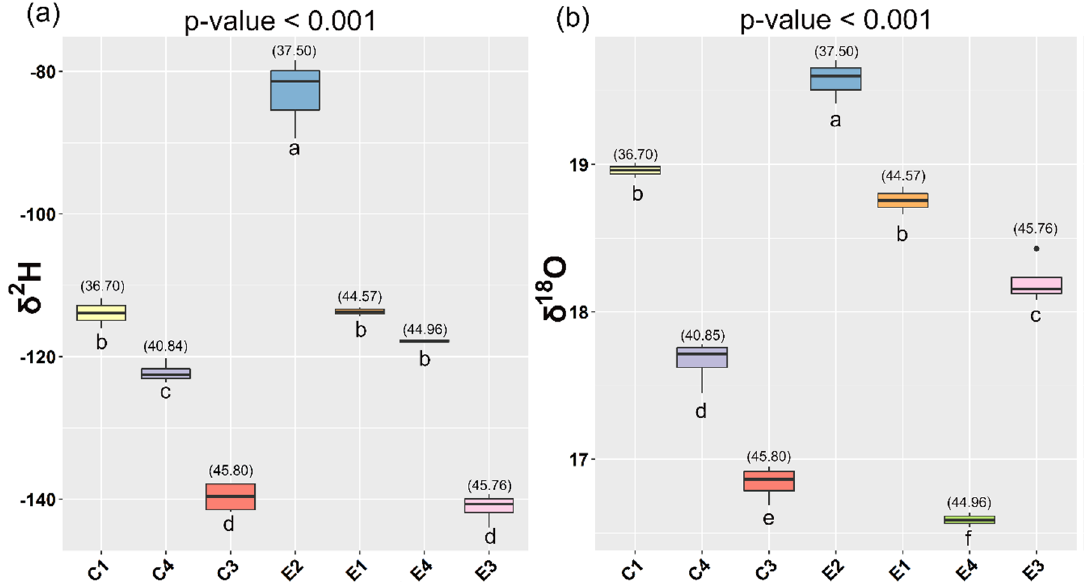
Figure 3. δ 2 H ( a ) and δ 18 O ( b ) values (‰) of muscle of E. sea bass reared in extensive systems and sea cages. The latitude of each group is shown in parenthesis. A one-way ANOVA was performed on the data and the letters below the boxes correspond to the Tukey HSD post hoc test.